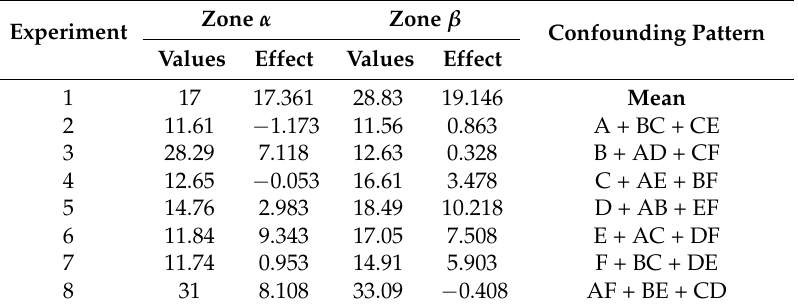
Table 9. Mean values and standardized effects for the Roundness parameter ( R ).